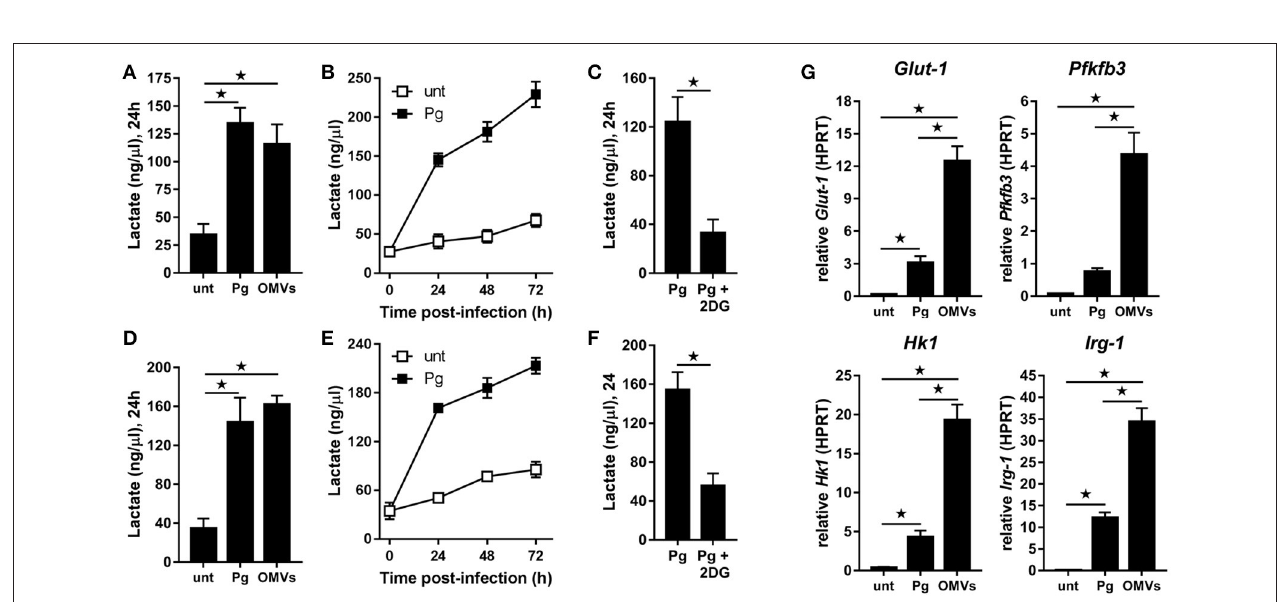
FIGURE 2 | P. gingivalis and its OMVs induce glycolysis in macrophages. Secreted lactate concentrations from murine BMM (A–C) and human MDM (D–F) at indicated times (24–72 h) after infection with P. gingivalis ( Pg ) or its OMVs (25:1 MOI) (see Materials and Methods). Macrophages were treated with 2DG (5 mM) as indicated. (G) Gene expression by qPCR of Glut-1, Pfkfb3, Hk-1, and Irg-1 were quantitated in BMM at 24 h (treated as in A ). Data are mean ± SD from four independent experiments (* p < 0.05).